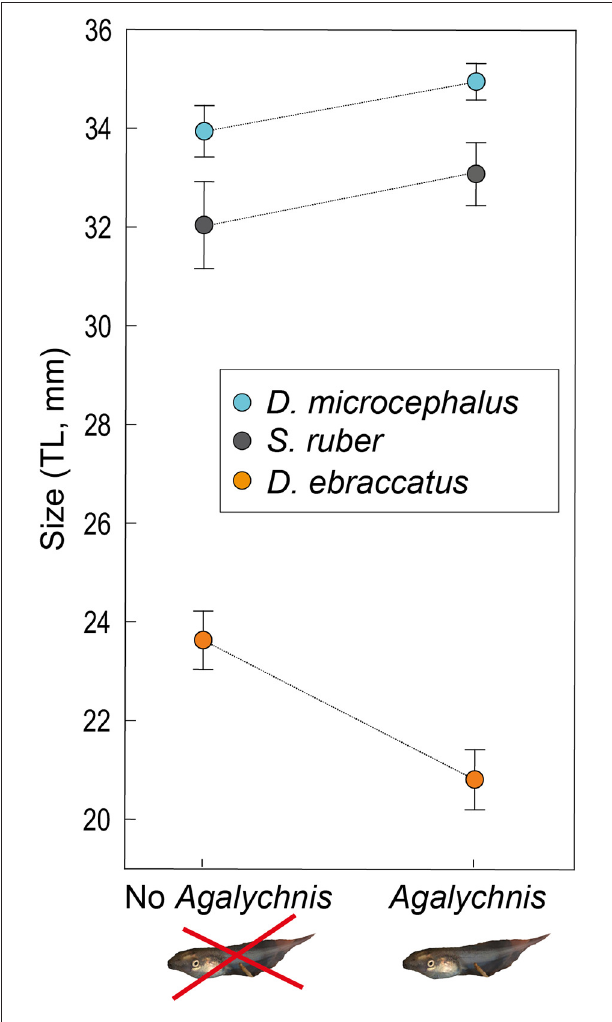
FIGURE 3 | Size at the end of the experiment (Total Length–TL- in mm, mean ± SE,) of D. microcephalus (blue circles), S. ruber (gray circles), and D. ebraccatus (orange circles), in the scenario without the species Agalychnis callidryas (“No Agalychnis,” the potential competitor) and with A. callidryas (“ Agalychnis” ). All tadpole photos by JT.